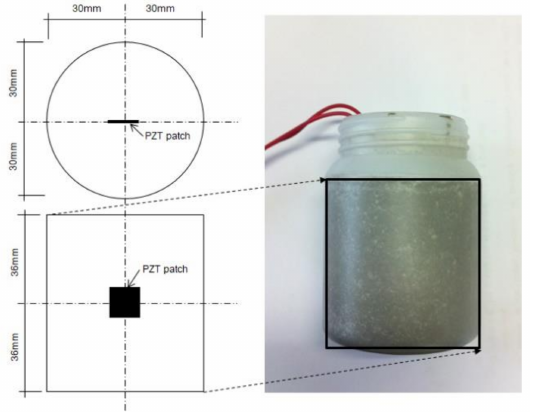
Figure 2. Cement paste sample and embedding position of PZT patch.